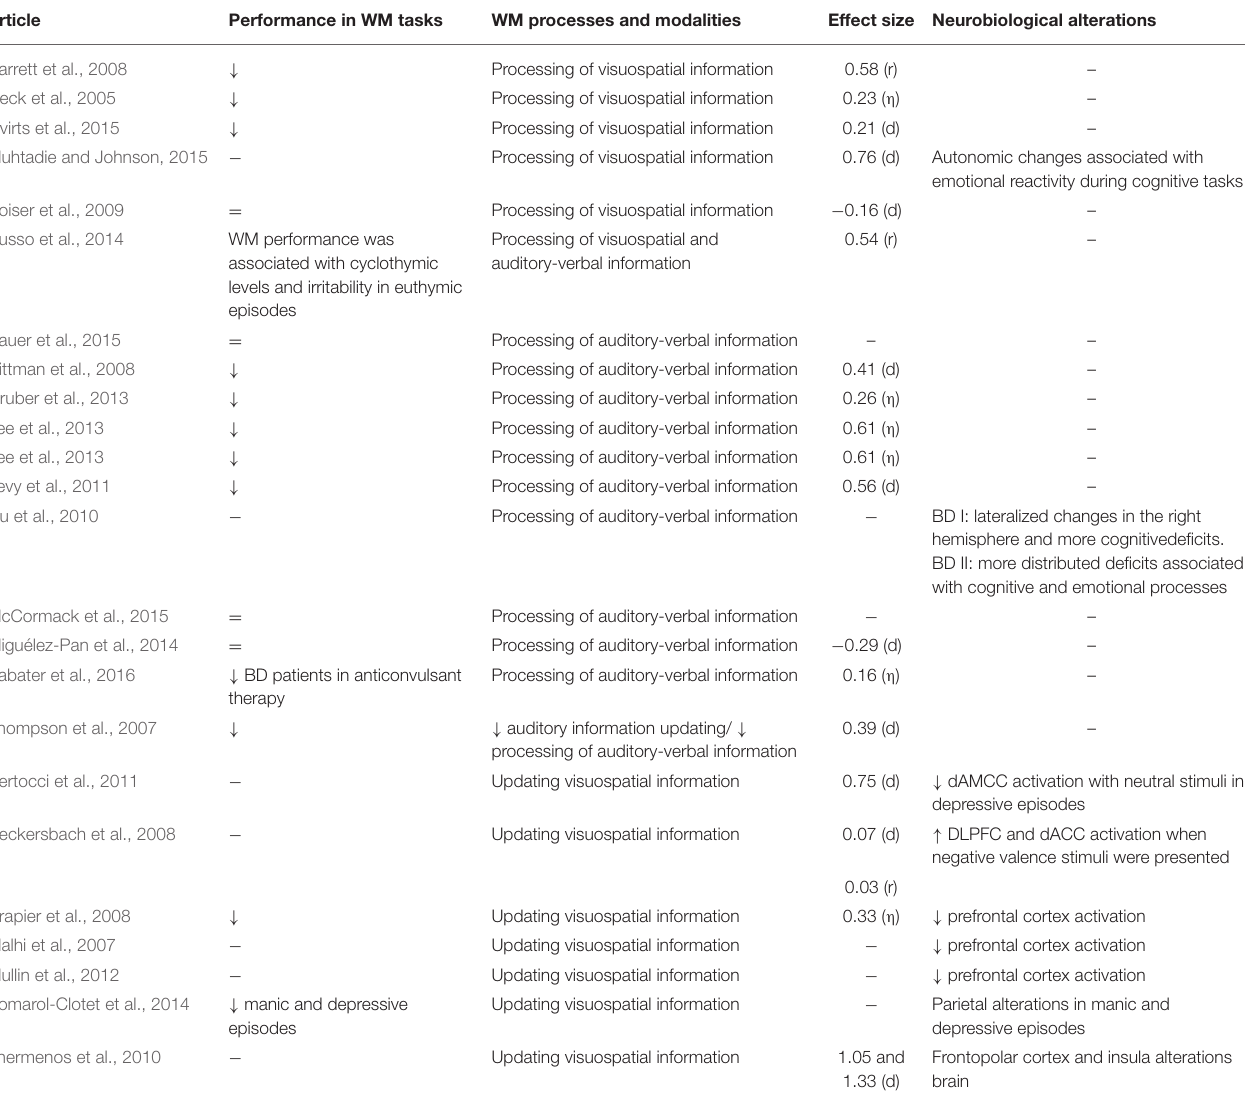
TABLE 3 | Summary of WM performance and neurobiological changes in BD subjects in selected articles categorized according WM processes and